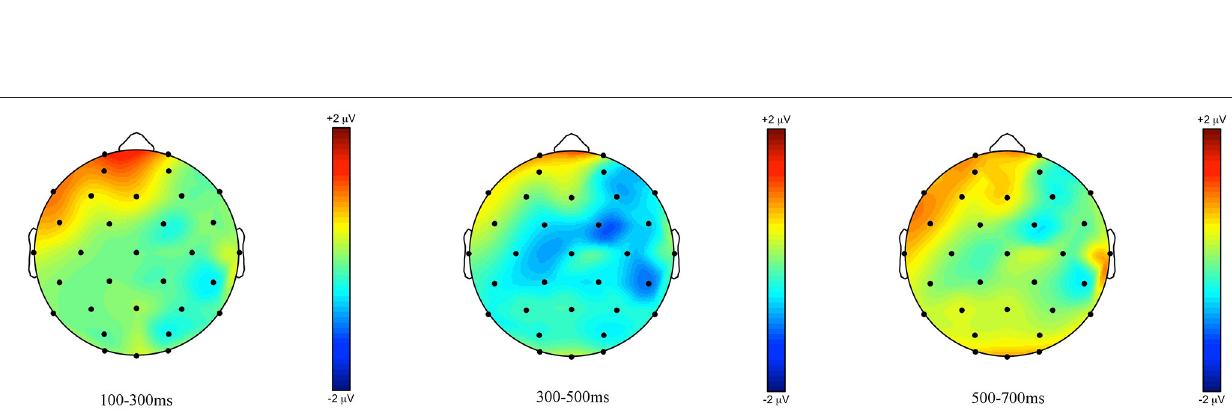
FIGURE 5 | Grand-averaged ERPs recorded in adults, time-locked to the presentation of the word “Alle” ( all ) for the some -infelicitous condition (black line) compared to the some -felicitous condition (red line).